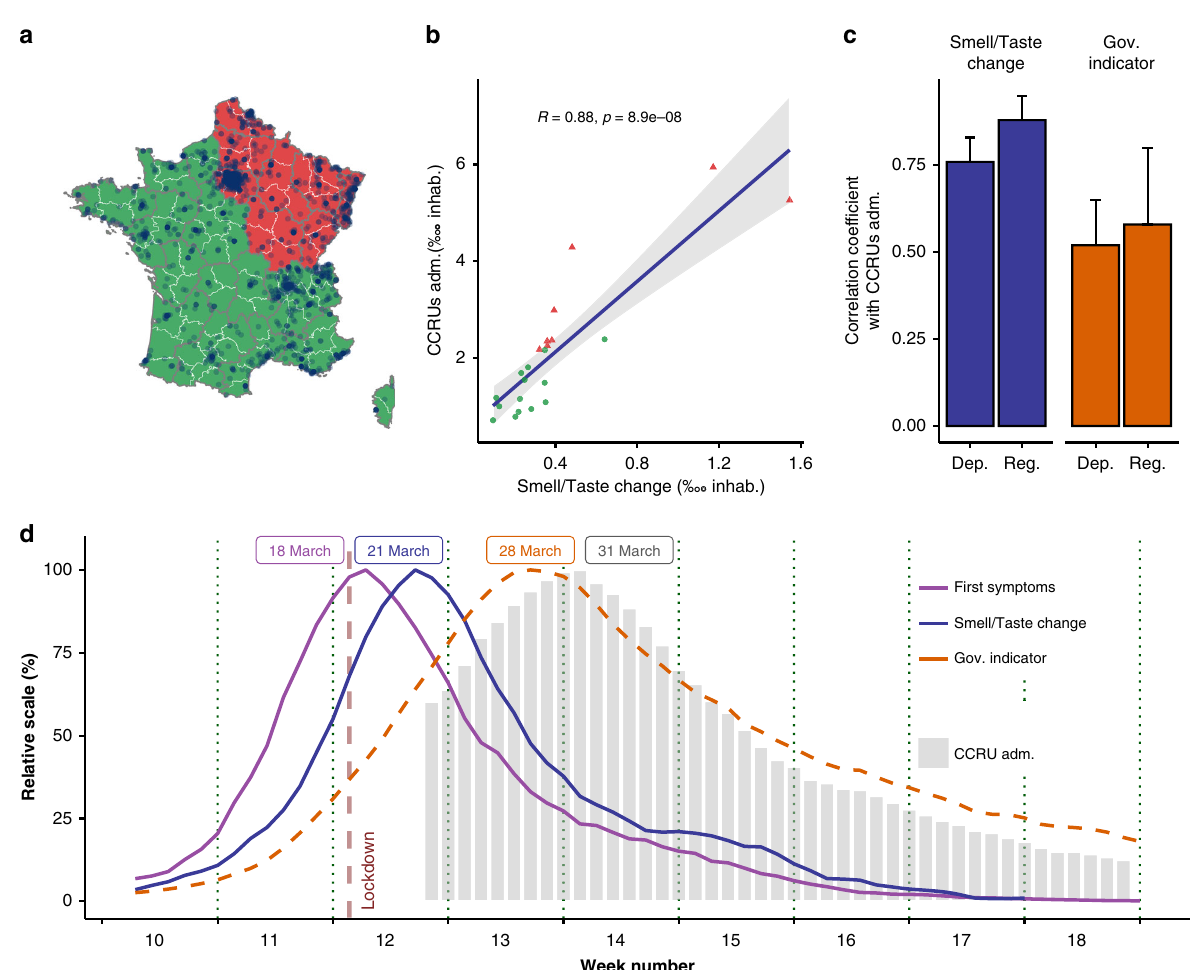
Fig. 1 Changes in smell and taste as indicators of overwhelmed healthcare systems: geographic and time-related approaches. a French regions were assigned a green or red status by the French government to guide local relaxation of lockdown protocols. Dots represent people self-reporting smell and taste changes in a web-based survey. Base map is from OpenStreetMap and OpenStreetMap Foundation. b The number of COVID-19-related CCRU admissions (as of May 11, 2020) correlated with the number of self-reported chemosensory changes (between March 1 and May 11, 2020, total n = 3832). Green dots correspond to regions with a post-lockdown level labeled green, and red triangles indicate regions considered red. Values are standardized based on the number of inhabitants (inhab.) for each regions. The two red triangles with CCRU admissions >5 are Alsace and Ile de France. The gray band represent the con fi dence interval of the linear smooth (formula ‘ y ~ x ’ ) R and p represent value of the test for association between paired samples, using one of Pearson ’ s product moment correlation coef fi cient, without correction for multiple comparisons. c Colored bar represent the value of computed correlation coef fi cients (con fi dence intervals are depicted as thin black bars) between the number of CCRU admissions per area and i) the number of people reporting smell and taste changes ( n = 3832, blue), and ii) the governmental indicator (Gov. indicator), ratio of ER consults for COVID-19 (orange). Analyses were done both at the level of metropolitan regions (Reg) and departments (Dep). d Temporal relationships in France between smell/taste change symptom onset (blue solid line, n = 1476), the governmental indicator (orange dashed line), and COVID-19 cases in CCRUs (gray bars) around the lockdown period (vertical dashed line). Data are 7-day running averages, normalized to the day with the highest